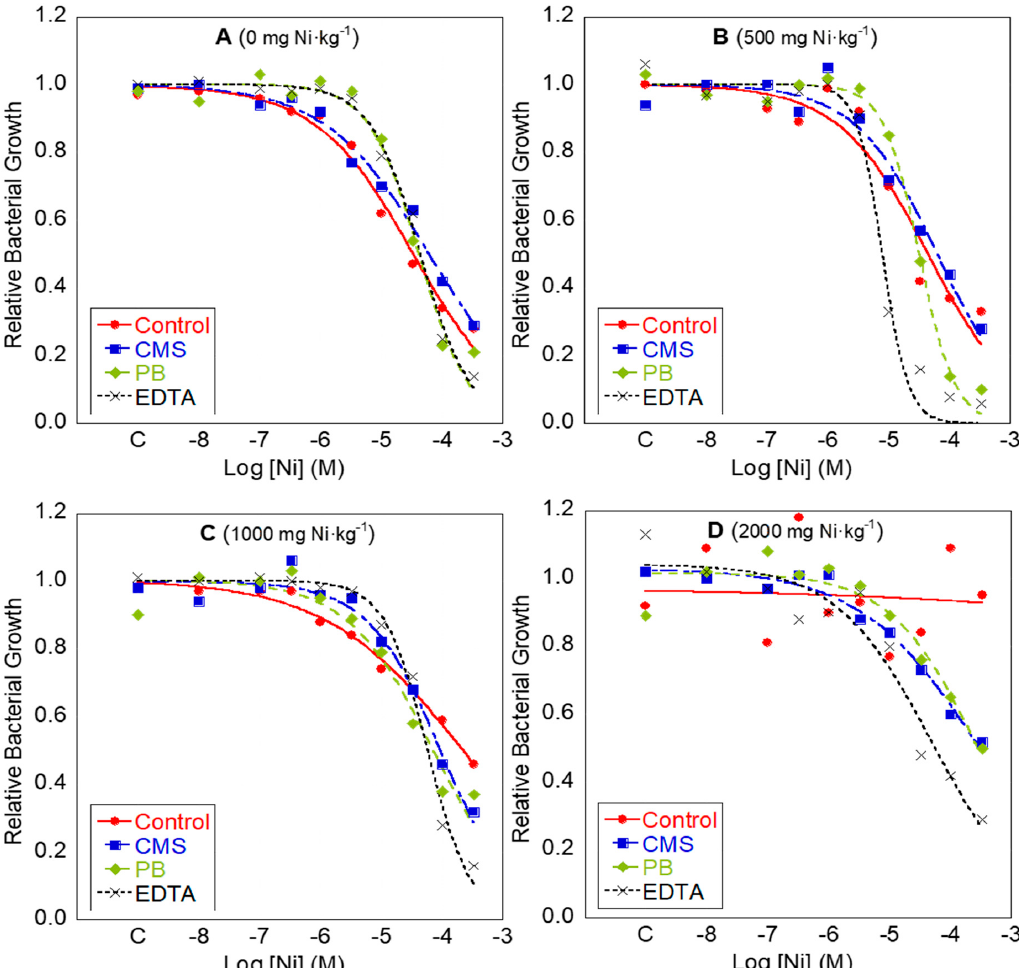
Figure 2. Dose–response curves of relative bacterial growth versus added Ni to bacterial suspensions from a polluted soil with four Ni levels: 0 ( A ), 500 ( B ), 1000 ( C ), and 2000 ( D ) mg Ni·kg − 1 . Each Ni level was remediated with four treatments: crushed mussel shell amendment (CMS, blue dots and line), pine bark amendment (PB, green dots and line), EDTA washing (black dots and line), and control (red dots and line).